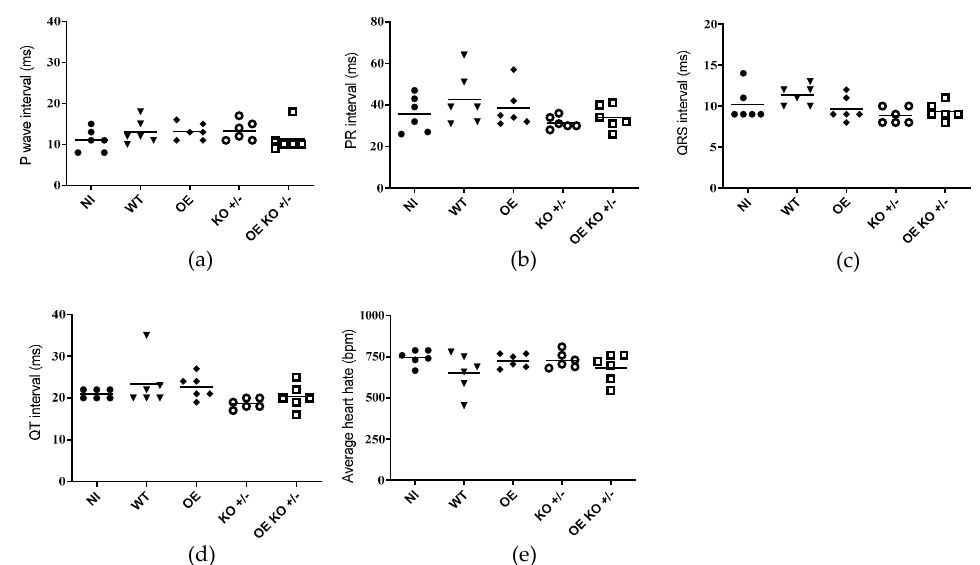
Figure 4. Graphical analysis of the presence of arrhythmias (individual heart rate), P wave and PR, QRS and QT intervals of mice non-infected (NI) or infected with (wild type) WT, (overexpressed) OE, (hemi-knockout) KO +/ − , and (overexpressed hemi-knockout) OE KO +/ − at 30 dpi. ( a – e ): P wave interval, PR, QRS, and QT intervals and heart rate, respectively. (ms): Milliseconds. (bpm): Beats per minute.